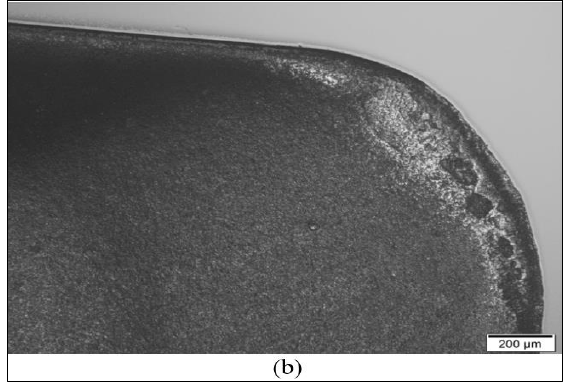
Figure 9b: Wear on the cutting tool rake surface with insert 0,8 mm: (b) With sealant. Source: Authors, (2022).